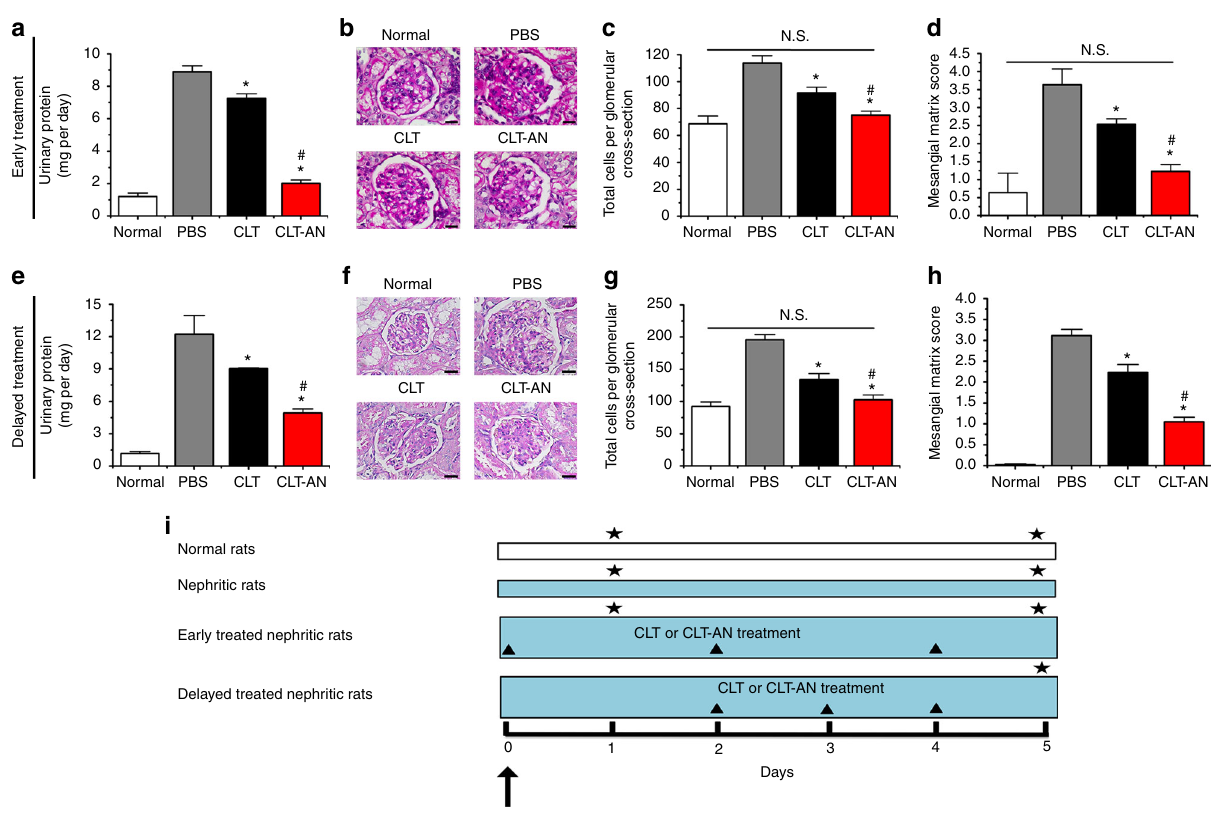
Fig. 4 Enhanced ef fi cacy of CLT-AN in the reversible model. a Effects of early CLT or CLT-AN treatment on 24-h urinary protein excretion in anti-Thy1.1 nephritic rats on day 5 after disease induction. b Glomerular histology revealed by PAS staining of kidney tissue sections from anti-Thy1.1 nephritic rats on day 5 after early treatment with CLT or CLT-AN. Scale bars , 20 μ m. c Effects of early CLT or CLT-AN treatment on total glomerular cellularity on day 5 after disease induction. For each animal group, 150 glomeruli were selected and total glomerular cells were counted using cellSens Standard digital imaging software (Olympus). d Effects of early CLT or CLT-AN treatment on ECM deposition on day 5 after disease induction. For each animal group, 150 glomeruli were analyzed and ECM deposition was graded semiquantitatively as described in Methods. e Effects of delayed CLT or CLT-AN treatment on 24-h urinary protein excretion in anti-Thy1.1 nephritic rats on day 5 after disease induction. f Glomerular histology revealed by PAS staining of kidney tissue sections from anti-Thy1.1 nephritic rats on day 5 after delayed treatment with CLT or CLT-AN. Scale bars , 20 μ m. g Effects of delayed CLT or CLT-AN treatment on total glomerular cellularity on day 5 after disease induction. h Effects of delayed CLT or CLT-AN treatment on ECM deposition on day 5 after disease induction. In panels a , c , d , e , g , and h data are mean ± s.d. ( n = 5), results are representative of two independent experiments. N.S., not signi fi